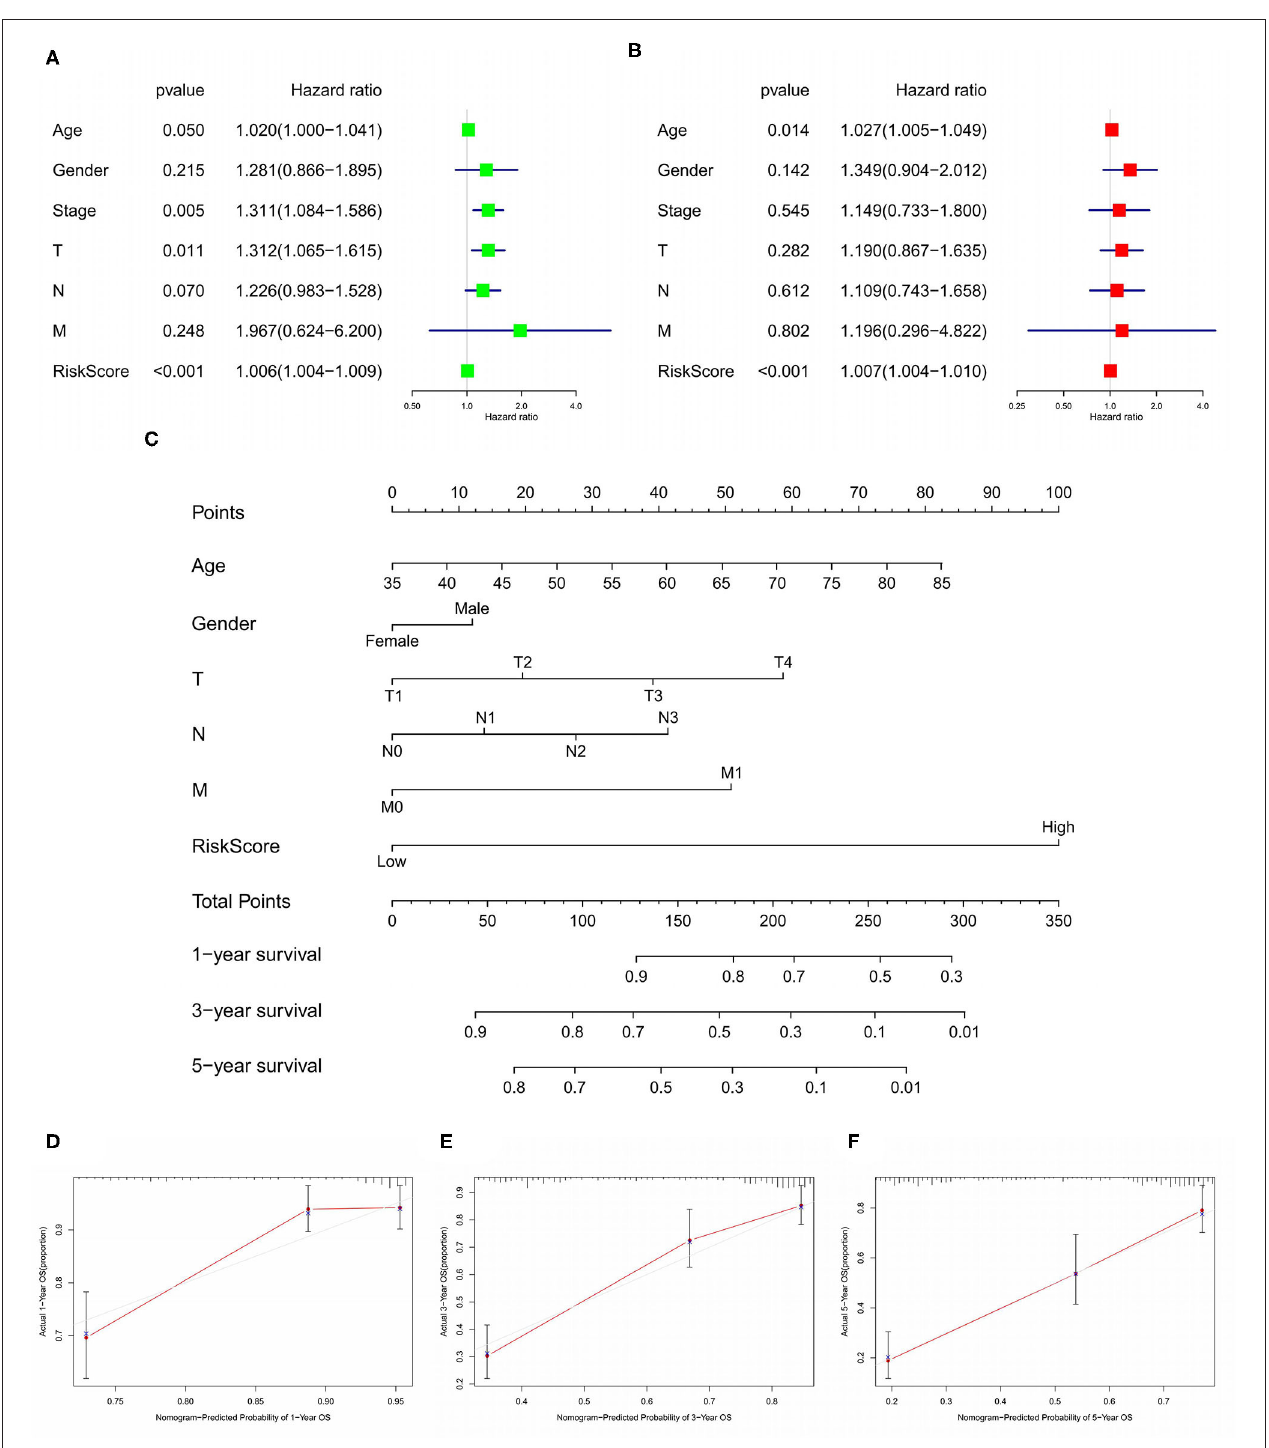
FIGURE 8 | Forest plots of Cox regression analysis for evaluating the independent prognostic value of the risk score (All) based on univariate analysis (A) and multivariate analysis (B) . Nomogram for predicting 1-, 3-, and 5-year OS of LUSC patients (C) . Calibration curves for the survival probability of 1, 3, or 5 years (D–F) . OS, overall survival; LUSC, lung squamous cell